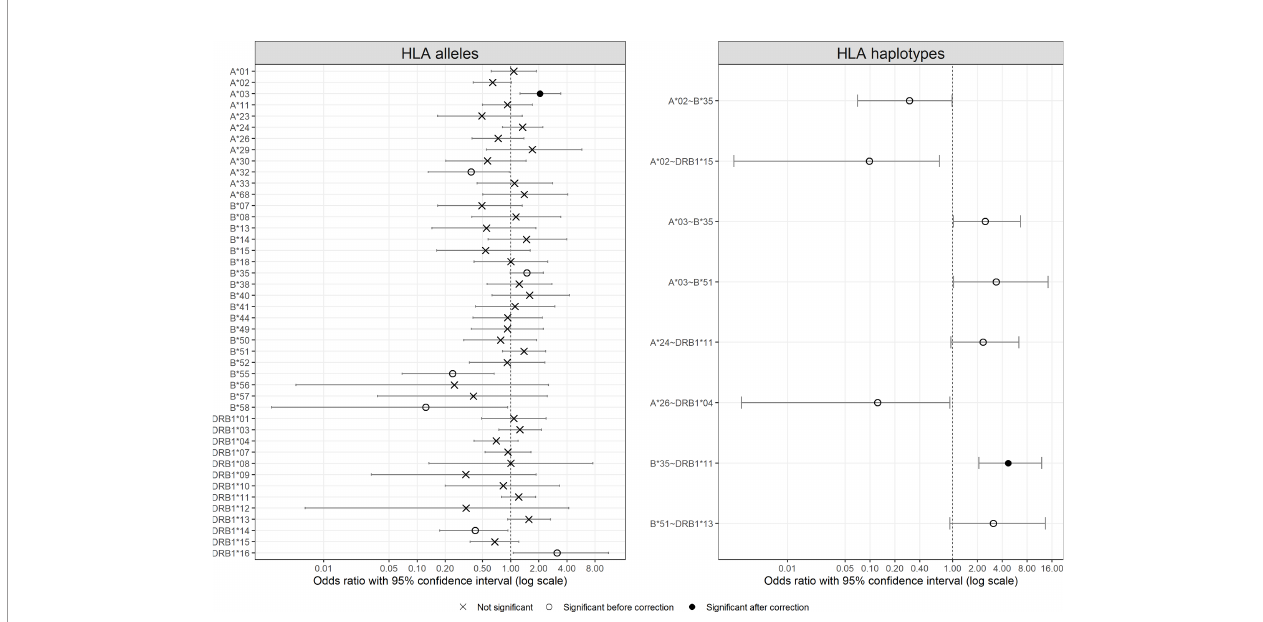
Figure 2 visualizes odds ratios with 95% con fi dence interval estimated for HLA-A , -B , and -DRB1 alleles and results of Fisher ’ s exact test between patients and controls (detailed results are listed in Supplementary Table 5 ). Among HLA alleles, A*03 (OR = 2.06, p = 0.0025), B*35 (OR = 1.49, p = 0.0494), and DRB1*16 (OR = 3.13, p = 0.0237) were signi fi cantly more frequent in the patient group (susceptible), whereas A*32 (OR = 0.38, p = 0.0388), B*55 (OR = 0.24, p = 0.0033), B*58 (OR = 0.12, p = 0.0376), and DRB1*14 (OR = 0.42, p = 0.0300) were signi fi cantly more prevalent in the control group (protective).